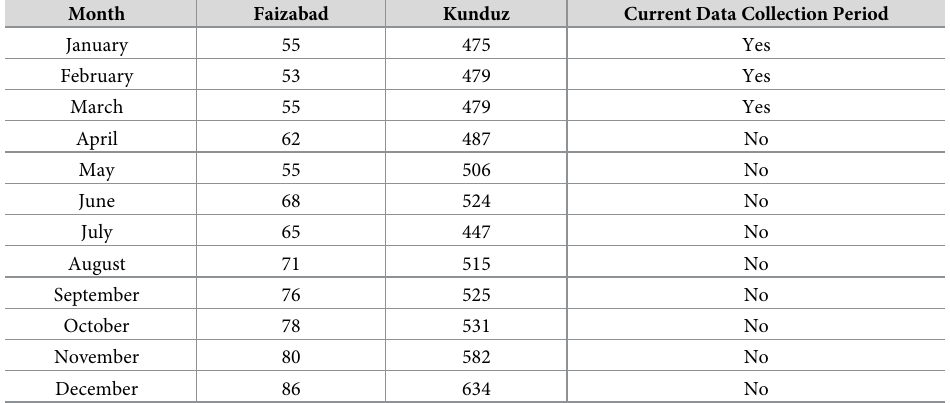
Table 3. Number of people who inject drugs (PWID) receiving services over 12 months in 2018 in Faizabad and Kunduz,